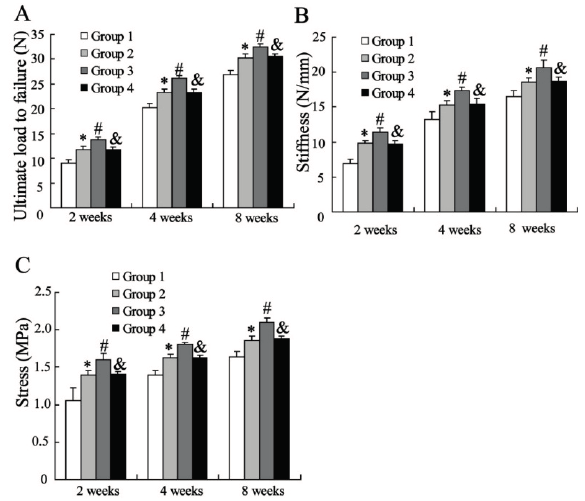
Figure 2. Biomechanical assessment of the tendon at the insertion site: ( A ) Ultimate load to failure; ( B ) Stiffness; ( C ) Stress. Data were shown as mean ± SD. * vs. Group1 (Injection with medium), p < 0.05; # vs. Group2 (Injection with MSCs), p < 0.05; and & vs. Group 3 (Injection with CXC chemokine ligand-13 (CXCL13) treated MSCs), p < 0.05. Group 4 is the specimens injected with CXCL13 treated MSCs accompanied by infection with lentiviruses of silencing CXCR5.